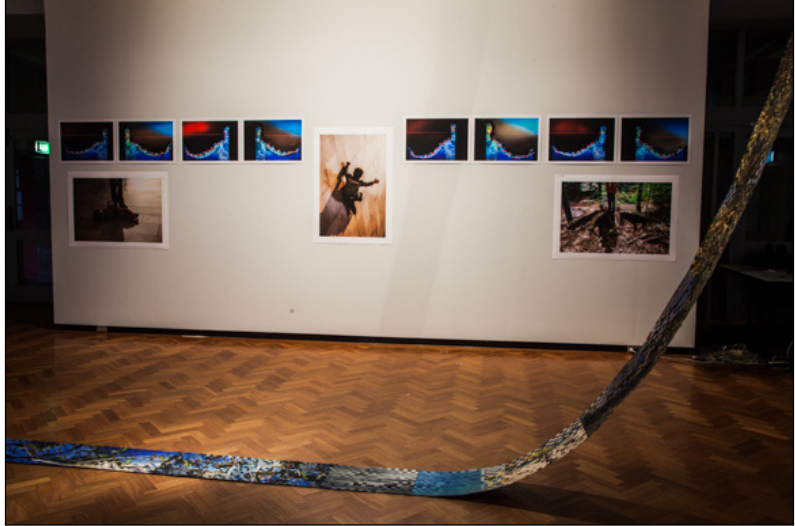
Figure 5. When I Was A Buoyant ( centre ) in Facing Futures Free From Fear (2013).